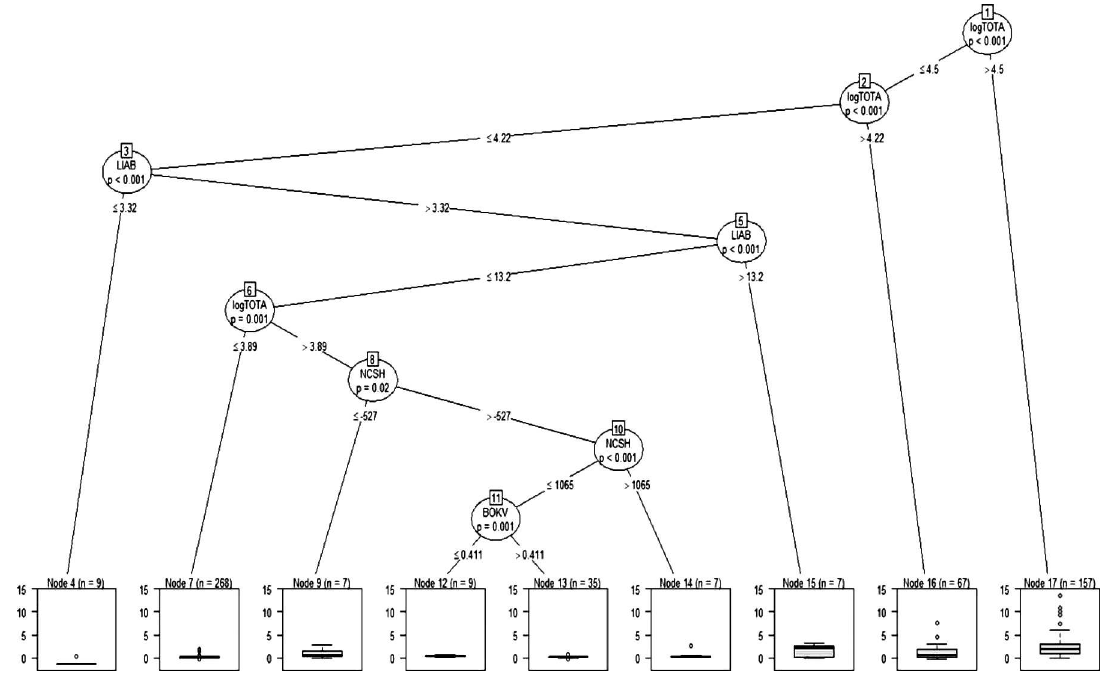
Figure 7. Conditional inference tree for EPS